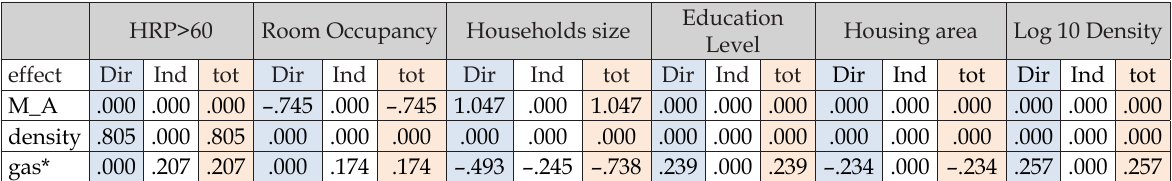
Table 8. Direct, indirect and total effect of household, housing and density variables on per-capita gas con -